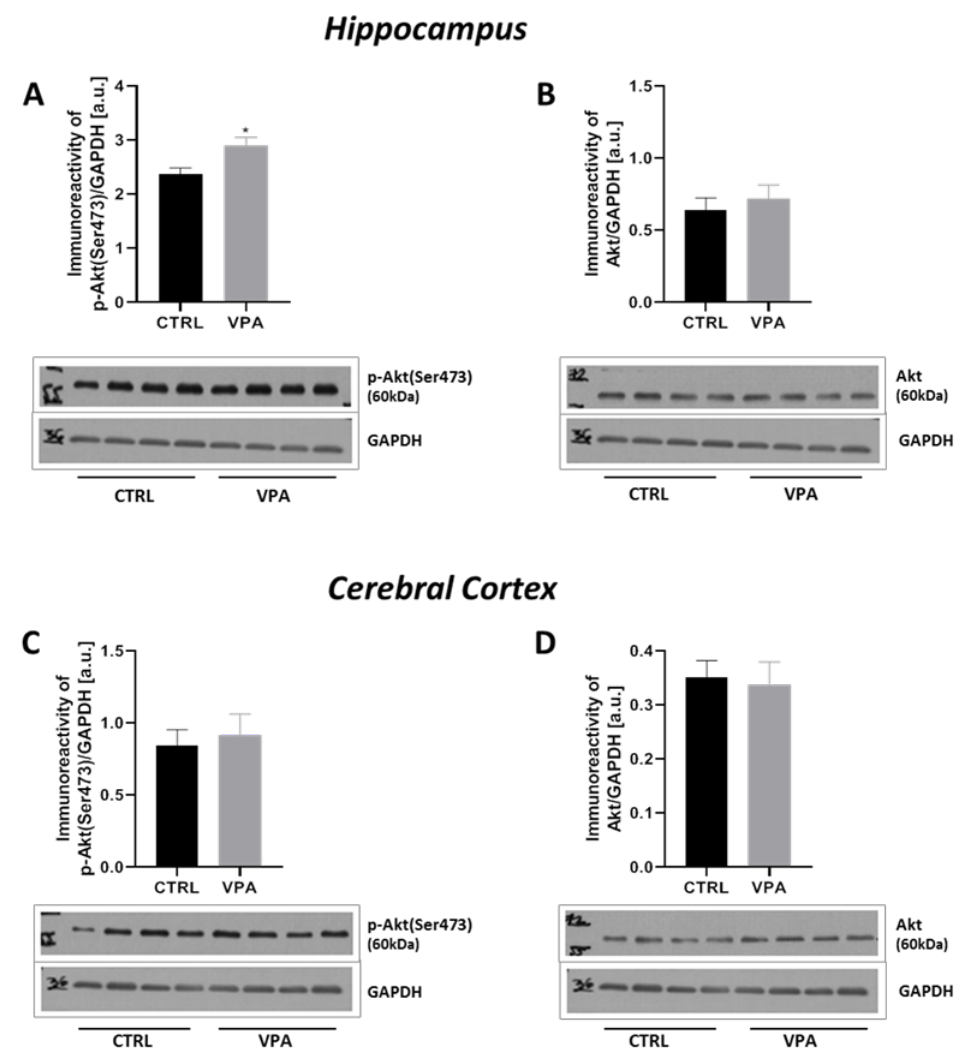
Figure 10. The effect of prenatal exposure to VPA on the Akt in the rat brain. Immunoreactivity of p-Akt(Ser473) and total Akt were determined using Western blot analysis. Densitometric analysis and representative pictures of p-Akt(Ser473) and total Akt in the hippocampus ( A , B ) and cerebral cortex ( C , D ) were shown. Results were normalized to GAPDH levels. Data represent the means ± S.E.M. from n = (8–9) independent experiments in the hippocampus: ( A ) n = 9 (CTRL), n = 8 (VPA); ( B ) n = 9 (CTRL), n = 8 (VPA); and n = (7–9) in the cerebral cortex: ( C ) n = 9 (CTRL), n = 8 (VPA); ( D ) n = 9 (CTRL), n = 7 (VPA). * p < 0.5, vs. control.